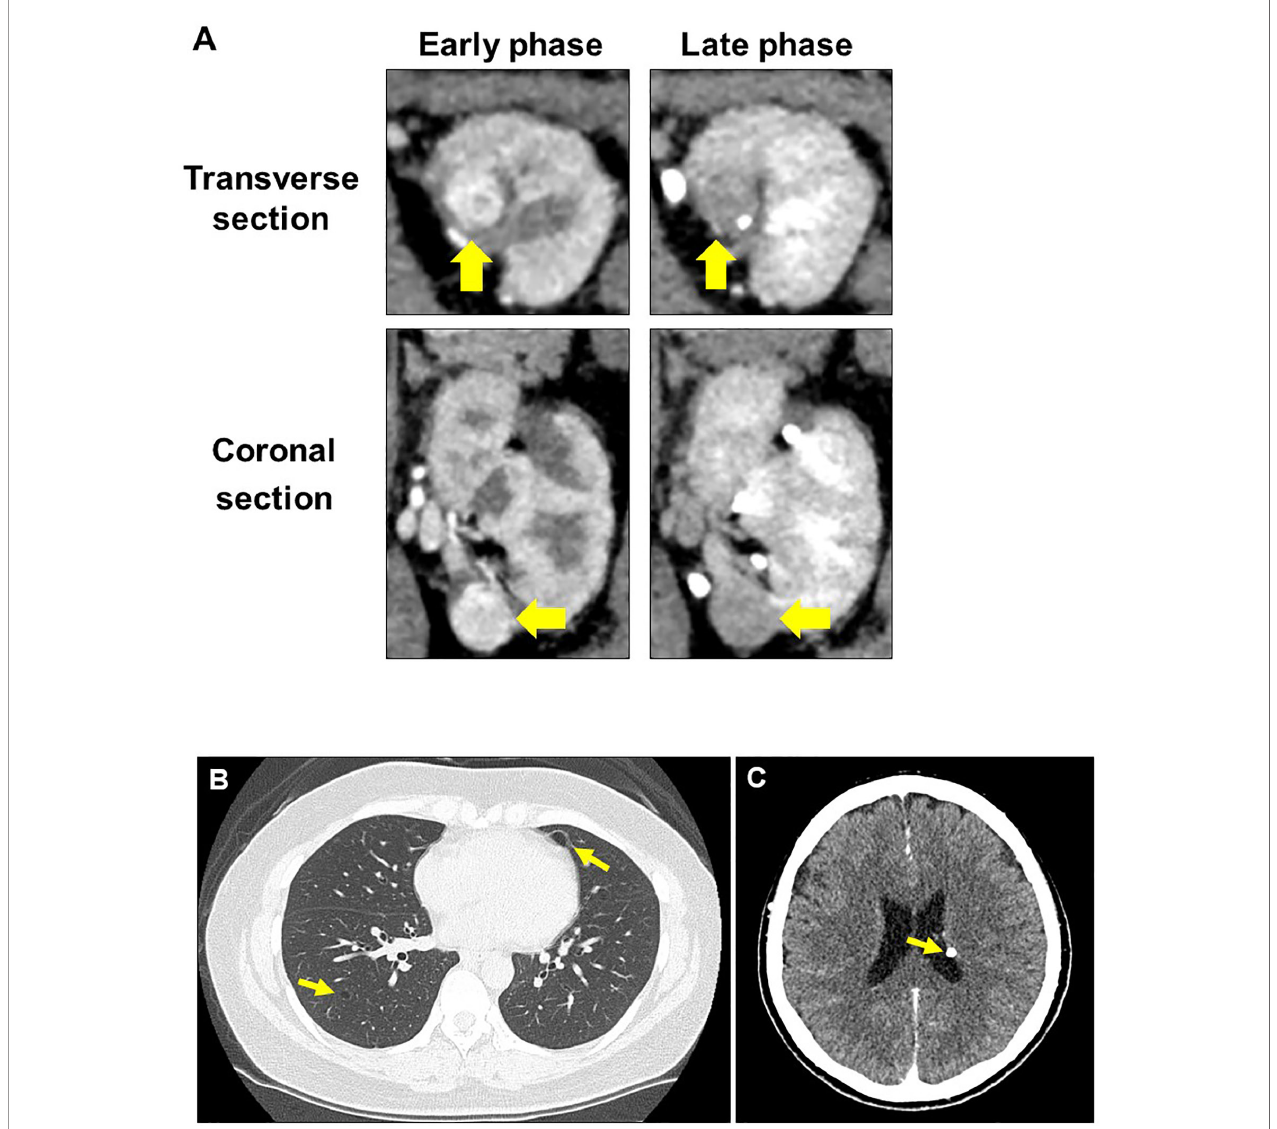
FIGURE 2 | Radiographic evaluation at second recurrence. (A) Computed tomography examination shows typical fi ndings of clear cell renal cell carcinoma in the left kidney. (B) Lung lymphangioleiomyomatosis. (C) Subependymal nodule at the left lateral ventricular wall of the